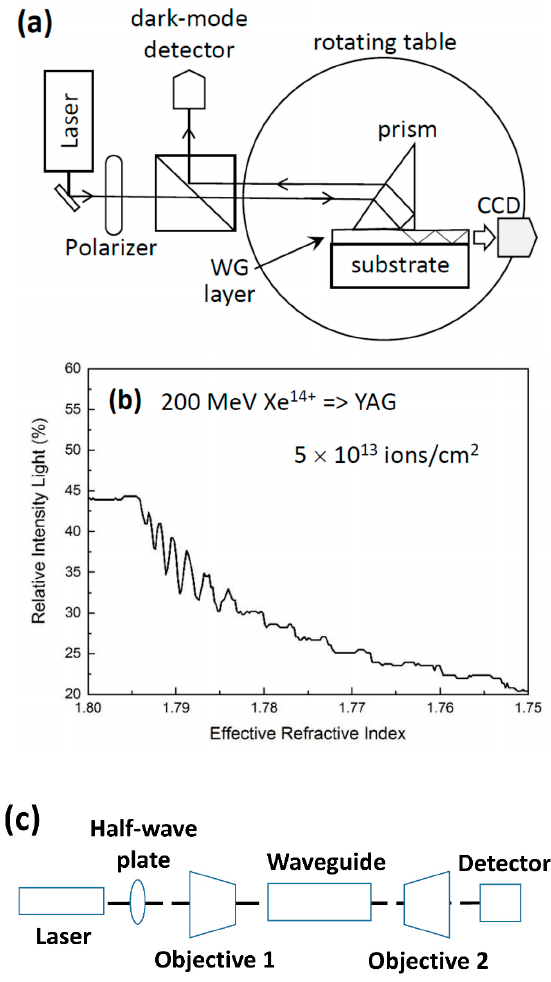
Figure 3. ( a ) a setup for detection of waveguide modes using prism coupling and the dark-mode detection. See text for details. ( b ) a typical data of the dark-mode detection from YAG sample irradiated with 200 MeV Xe ions in the TE mode. Each dip corresponds to a waveguides (WG) modes. ( c ) a setup of the end-face coupling. The polarization of the laser is controlled by a half-wave plate. The WG modes were searched with scanning the WG angle or equivalently the effective